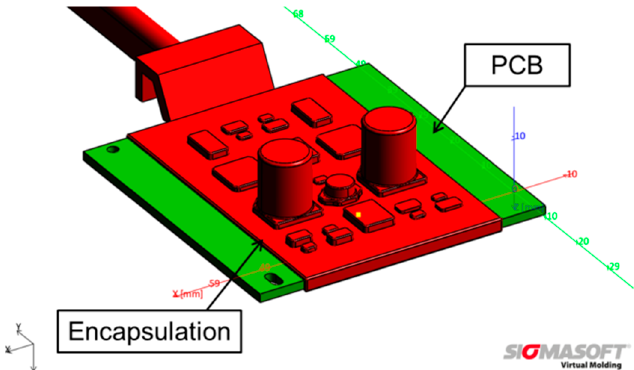
Figure A1. Geometry Model used for the process simulation. Table A1. Injection molding process parameters.